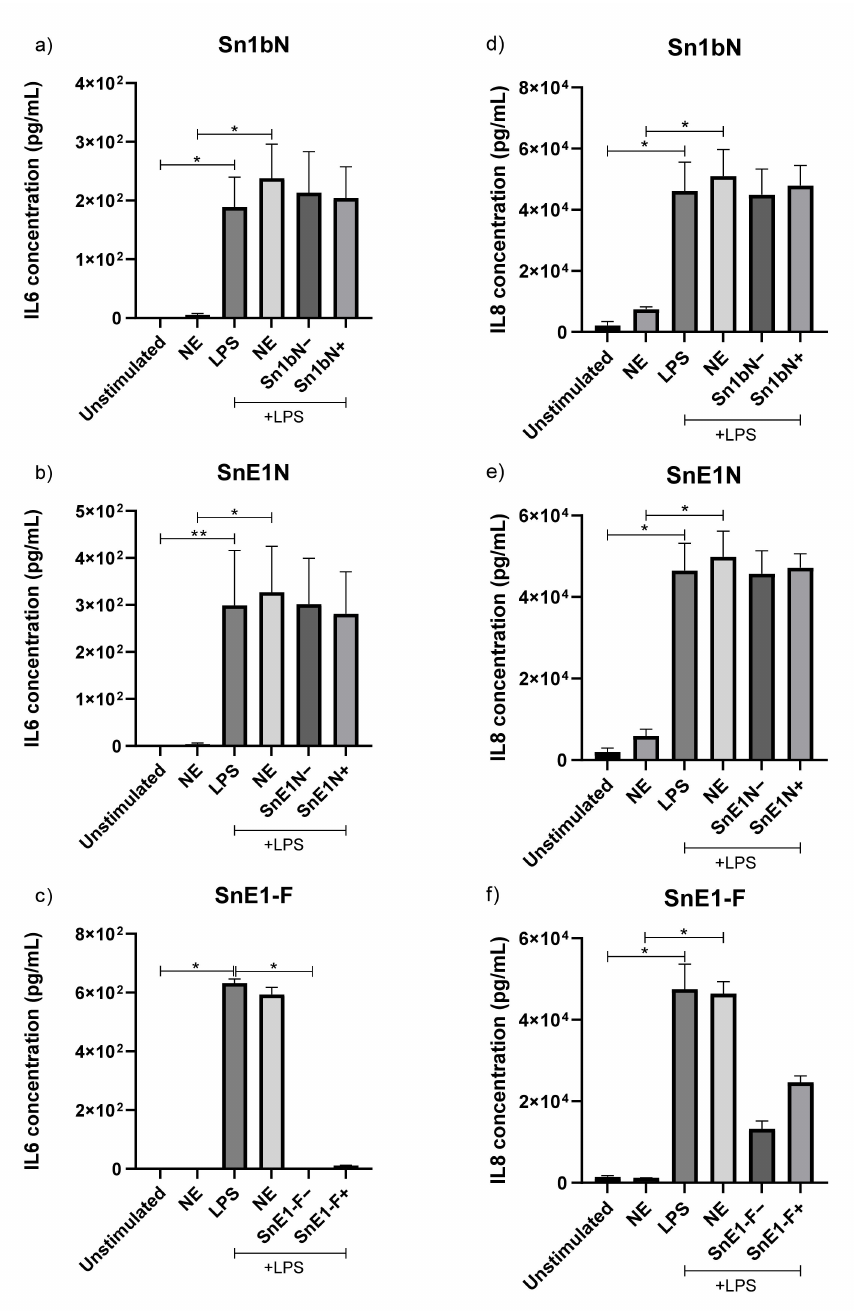
Figure 10. IL-6 and IL-8 concentrations in the supernatants of THP-1 monocyte-derived macrophages following incubation with NE-incubated next generation peptides and/or LPS. THP-1 monocyte- derived macrophages were incubated with/without LPS and/or NE-incubated ( a , d ) Sn1bN (1.6 µ M), ( b , e ) SnE1N (1.2 µ M) or ( c , f ) SnE1-F (1.2 µ M) for 16 h. ( a – c ) IL-6 and IL-8 ( d – f ) levels in cell supernatants were measured via ELISA. +/ − = incubation of peptide in the presence/absence of NE prior to experiment. Kruskal–Wallis with Dunn’s Multiple Comparison, * p < 0.05, ** p < 0.01. n =